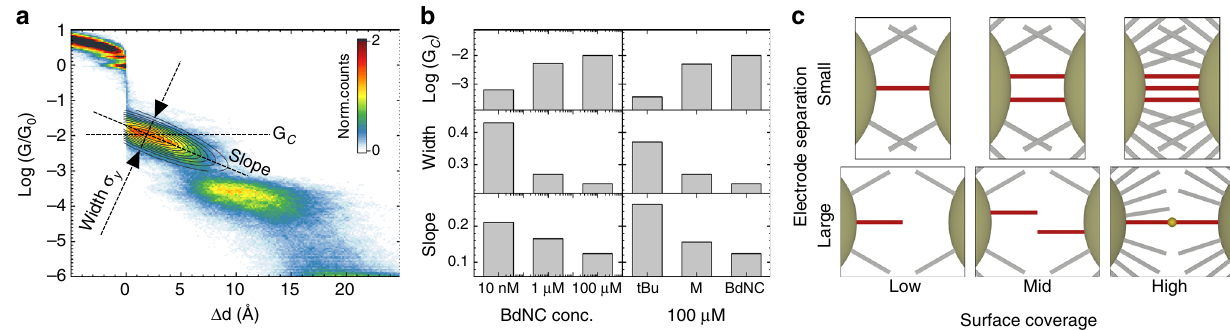
Fig. 5 Analysis of conductance plateaus. a Schematics of plateau shape analysis for 100 μ M BdNC measurements. b Plateau width, center and slope deduced from the shape analysis (see Supplementary Note 4 for more details). c Schematic sketch of the possible scenario ’ s for different surface coverages. Molecules connected to both electrodes are depicted in red, while the others are